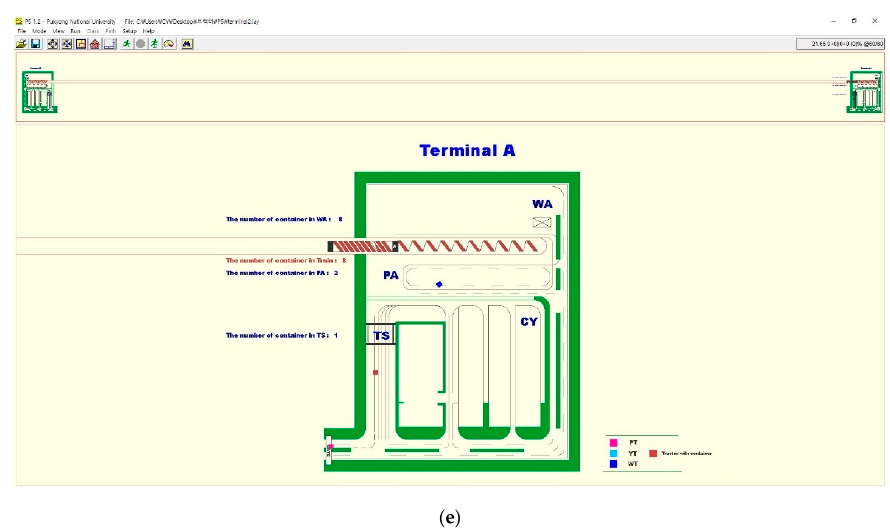
Figure 15. Visualization of the simulation results through animation: ( a ) outline of overall system; ( b ) private tractor ACT; ( c ) yard tractor ACT 1; ( d ) yard tractor ACT 2; ( e ) yard tractor ACT in the waiting area.